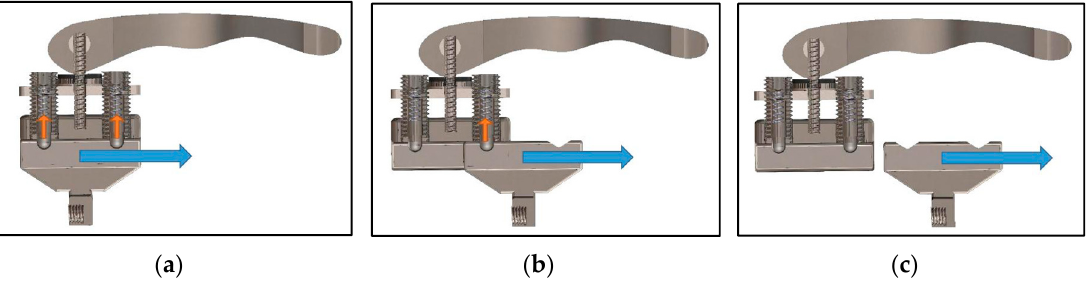
Figure 1. Sliding release mechanism: ( a ) Locked; ( b ) Intermediate Release; ( c ) Complete Release.